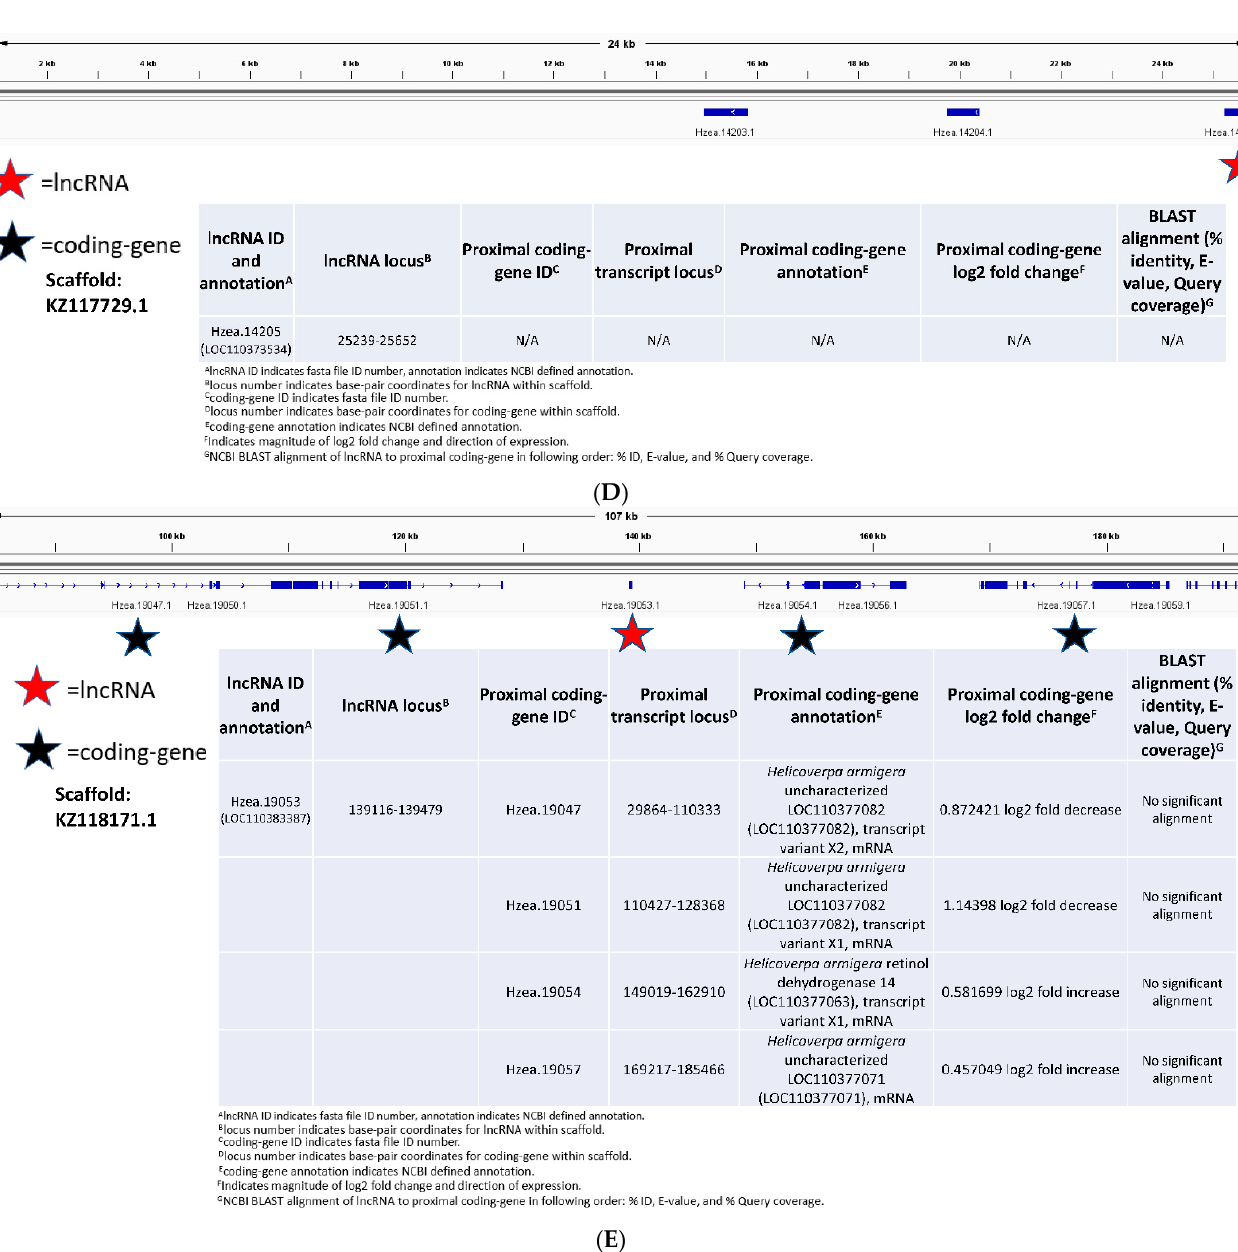
Figure 4. Genomic scaffold for lncRNAs and identification of proximal protein-coding genes. The scaffold at the top of each ( A – E ) depicts the range of the scaffold in kilobases (kb). The bars in blue indicate sequences present on each scaffold, with gene ID numbers below each. The red stars indicate a lncRNA; the black stars indicate a protein-coding gene. The scaffold ID number is placed directly below the legend on the left side. The table below the scaffold includes the following information about the lncRNA and coding genes found in the scaffold from left to right: the lncRNA ID number and annotation, lncRNA loci coordinates, gene ID number of the proximal coding gene, coding gene loci coordinates, coding gene annotation (NCBI defined), coding gene log2 fold change, and BLASTn alignment results (% identity, E-value, and query coverage) comparing the lncRNA and the protein-coding gene. Each subfigure depicts the following: ( A ), lncRNA LOC113506107 proximal to a CYP coding gene; ( B ), lncRNA 110369725 proximal to an ABC transporter coding gene; ( C ), lncRNA LOC110382674 proximal to a serine protease coding gene; ( D ), lncRNA LOC110373534 with no significant proximal coding genes; and ( E ), lncRNA LOC110383387 proximal to non-Bt-associated coding genes. All other proximity analyses can be found in Supplementary Figures S3–S6.